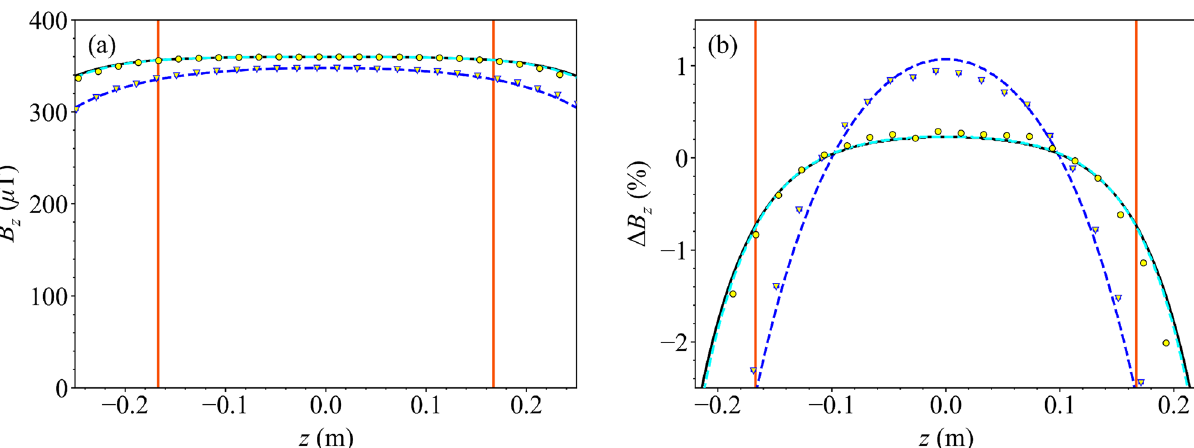
Figure 6. ( a ) Axial magnetic field generated by the uniform B z coil (current I = 500 mA) with/without the magnetic shield (black/dark blue) evaluated along the z -axis. Scatter points (yellow circle/triangle with black/ dark blue outline) show measured data and lines show theoretical field profiles calculated analytically from the theoretical model (solid black) or numerically via the Biot–Savart law (dashed dark blue). An additional numerical simulation shows the field generated by the discrete coil configuration inside the standalone shield, excluding the atomic package (dashed cyan; COMSOL Multiphysics Version 5.3a). Overlaid lines (solid red) show the edges of the optimisation region. ( b ) Deviation from perfect uniformity of the normalised axial field, (cid:31) B z = B z − 1 , along the z -axis. Labelled identically to ( a